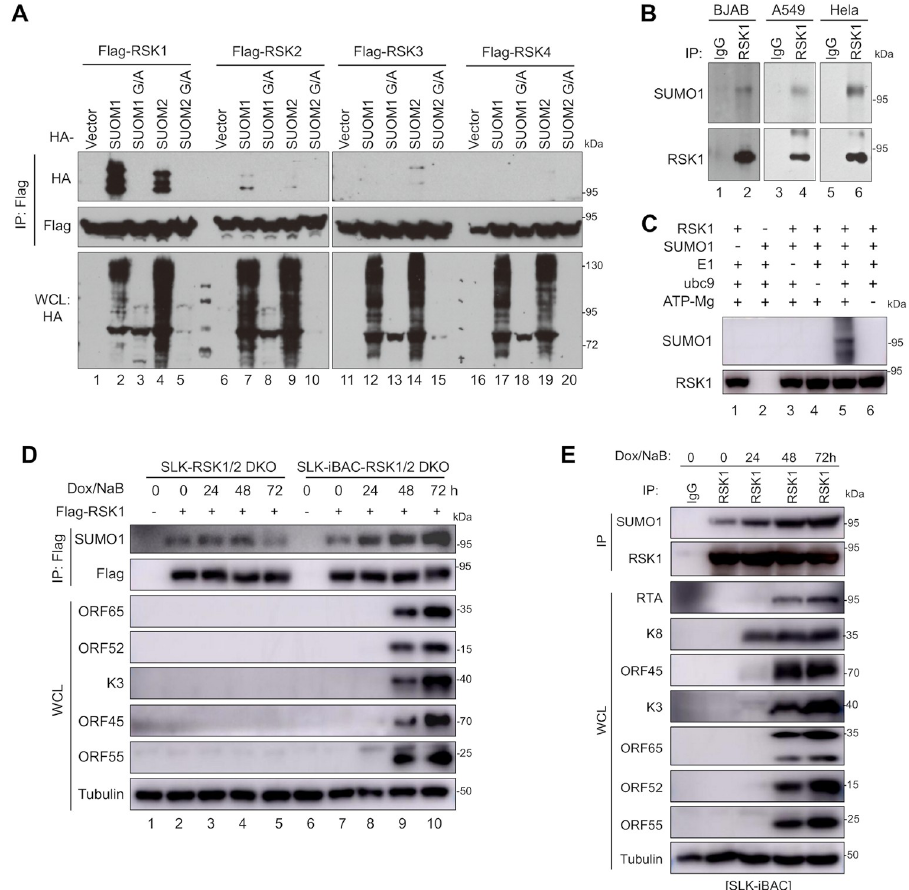
Fig 1. RSK1 undergoes SUMOylation during KSHV lytic replication. (A) RSK1 is highly SUMOylated in cells. HEK293T cells were co-transfected with indicated plasmids and cell lysates were subjected to IP and IB with indicated antibodies. (B) Endogenous RSK1 is SUMOylated. Endogenous RSK1 was immunoprecipitated with anti-RSK1 or IgG (control) antibodies under denature condition from lysates of BJAB, A549, and HeLa cells and the co- immunoprecipitated proteins were analyzed by IB with indicated antibodies. (C) RSK1 is SUMOylated in vitro . Recombinant RSK1 was incubated with SAE1/UBA2 (E1), Ubc9 (E2), SUMO1, and ATP/Mg in SUMO reaction buffer. The SUMOylation of RSK1 were detected by indicated antibodies. (D) RSK1 SUMOylation is increased during KSHV lytic replication. The SLK RSK1/2 DKO -vector, or SLK RSK1/2 DKO -Flag-RSK1, SLK-iBAC RSK1/2 DKO -vector, or SLK- iBAC RSK1/2 DKO -Flag-RSK1 cells were treated with doxycycline (2 μ g/ml) and sodium butyrate (1 mM) to induce KSHV lytic replication. Cell lysates were harvested at indicated time points and subjected to IP under denature condition and IB with indicated antibodies. ( E ) The endogenous RSK1 SUMOylation is elevated during KSHV lytic replication. SLK-iBAC cells were treated with doxycycline (2 μ g/ml) and sodium butyrate (1 mM) to induce KSHV lytic replication. Cell lysates were harvested at indicated time points and subject to IP with anti-RSK1 or control IgG under denature condition and IB with indicated antibodies. tet response elements in the promoter of RTA to generate iBAC (GenBank accession number: OK358814) (S1 Fig), in which RTA expression is controlled by a Tet-On promoter on BACmid [19]. To aid detection of RSK1 SUMOylation, we stably expressed Flag-tagged RSK1 in SLK- iBAC cells with both RSK1 and RSK2 knockout by CRISPR-Cas9 (SLK RSK1/2 DKO -iBAC). SLK- iBAC cell entered lytic replication cycle upon doxycycline and sodium butyrate treatment as shown by immunoblots of several lytic genes in the time course (Fig 1D and 1E). RSK1 SUMOylation was detected in SLK RSK1/2 DKO -iBAC-Flag-RSK1 cells, and increased over time after induction of KSHV lytic replication (Fig 1D). The endogenous RSK1 SUMOylation was